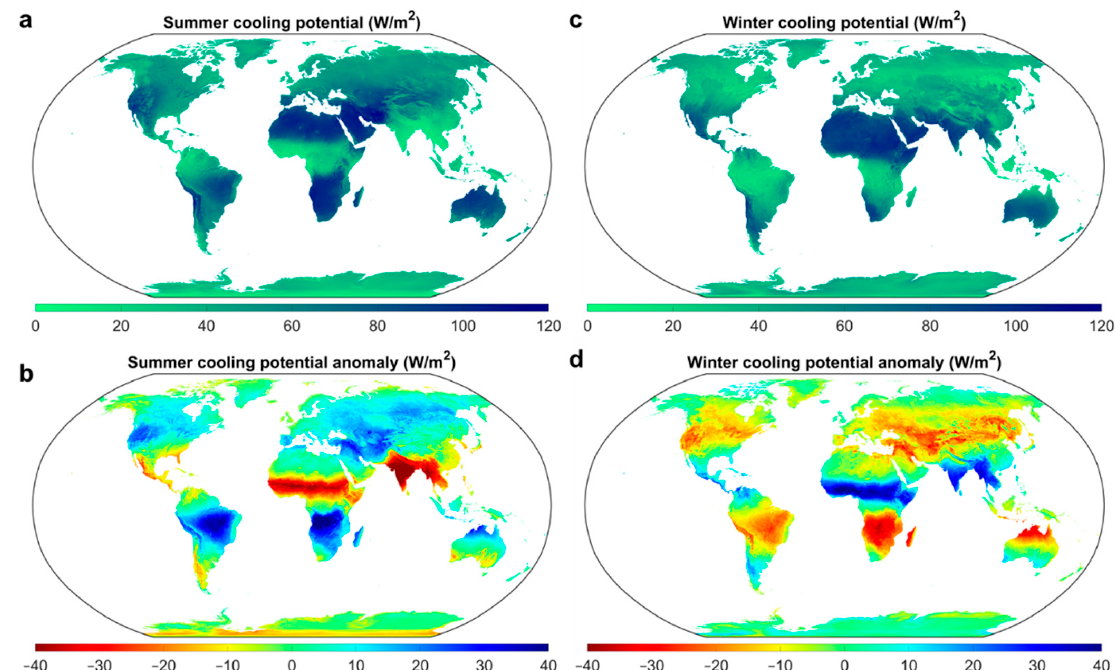
Figure 8. Global seasonal mean cooling potential maps (W/m 2 ). ( a , b ): The summer mean cooling potential and its anomaly, respectively. ( c , d ): The winter mean cooling potential and its anomaly, respectively. The cooling potential anomaly is defined as the deviation of seasonal mean cooling potential from the annual mean. A positive anomaly means an increase in the cooling potential and a negative anomaly means a reduction.